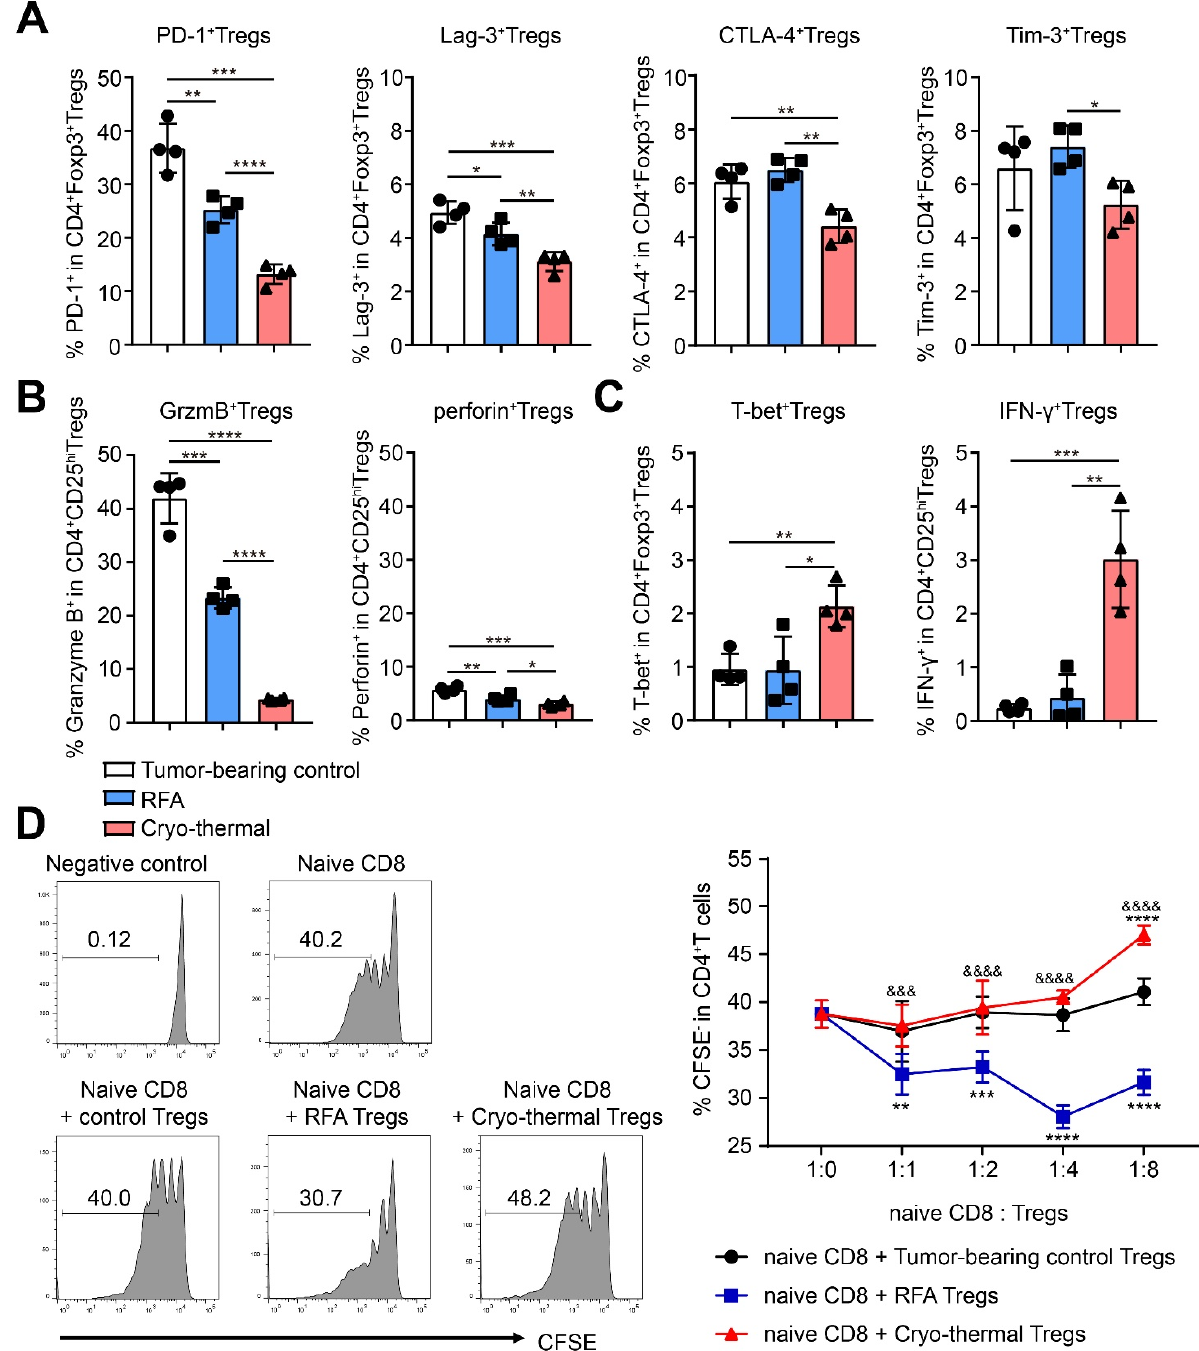
Figure 3. Cryo-thermal therapy drove the fragile phenotype of Tregs and down-regulated its suppressive function. ( A – D ) The expression level of inhibitory checkpoint molecules ( A ), suppressive cytokines Granzyme B and perforin ( B ), and T-bet and IFN- γ expression ( C ) on splenic Tregs from tumor-bearing control (39 days after inoculation), RFA or cryo-thermal therapy (21 days after treatment) were detected by flow cytometry. ( D ) Splenic Tregs from tumor-bearing control (39 days after inoculation), RFA or cryo-thermal therapy (21 days after treatment) and splenic CD8 + T cells from naïve mice were isolated through microbeads. CD8 + T cells were labeled with CFSE and then co-cultured with Tregs in different E/T ratio. α CD3 (1 ng/mL) was used to stimulated the proliferation of CD8 + T cells. After 72 h, the proliferated CD8 + T cells (CFSE-) were tested by flow cytometry. * p < 0.05, ** p < 0.01, *** p < 0.001, **** p < 0.0001 compared with the E/T ratio of 0:1. &&& p < 0.001, &&&& p < 0.0001 compared with the same E/T ratio of group RFA. N = 4 for each